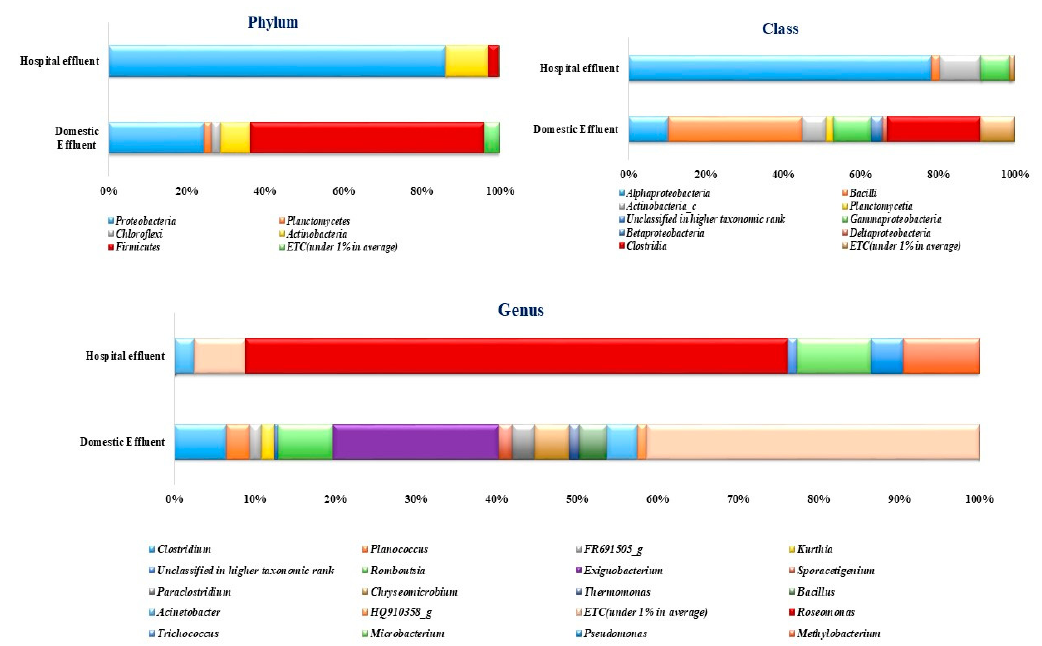
Figure 3. Taxonomic profiling of bacterial communities at the phylum level, class level and genus level in the collected hospital and domestic effluents.